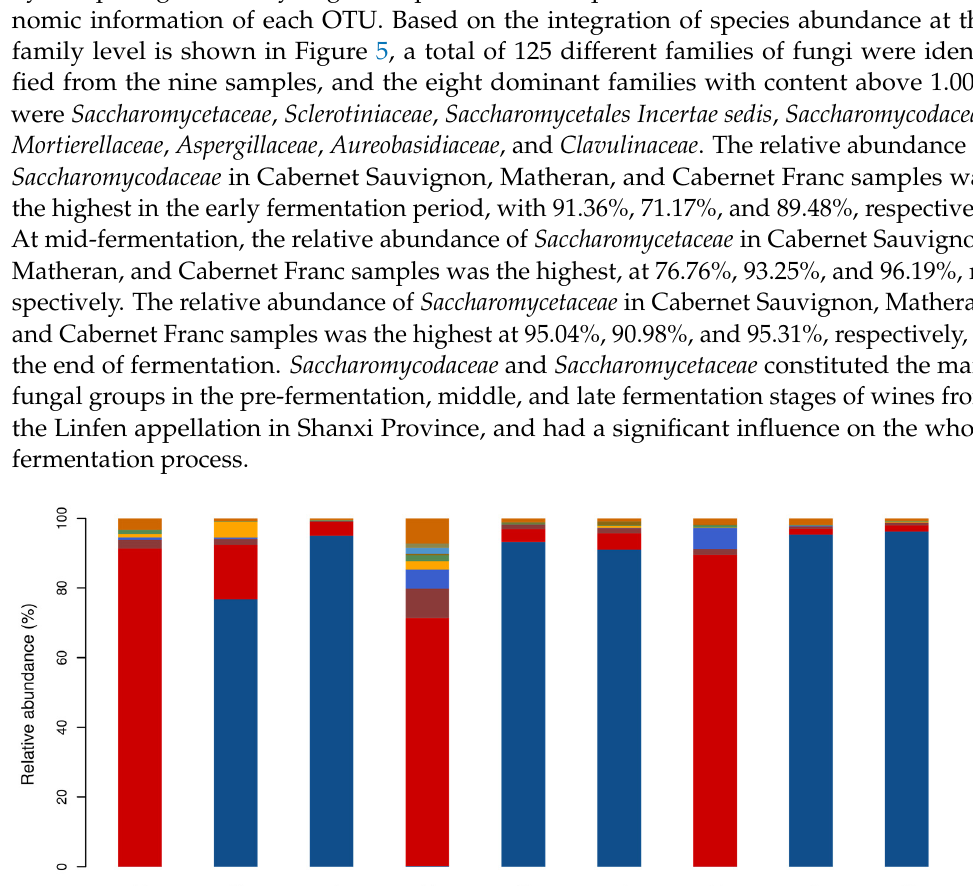
Figure 6. Histogram of species composition of genus-level samples. CAI is the pre-fermentation Cabernet Sauvignon, CAM is the mid-fermentation Cabernet Sauvignon, and CAL is the late fer- mentation Cabernet Sauvignon. MAI is the pre-fermentation Matheran, MAM is the mid-fermenta- tion Matheran, and MAL is the late fermentation Matheran. PAI is the pre-fermentation Cabernet Franc, PAM is the mid-fermentation Cabernet Franc, and PAL is the late fermentation Cabernet Franc.